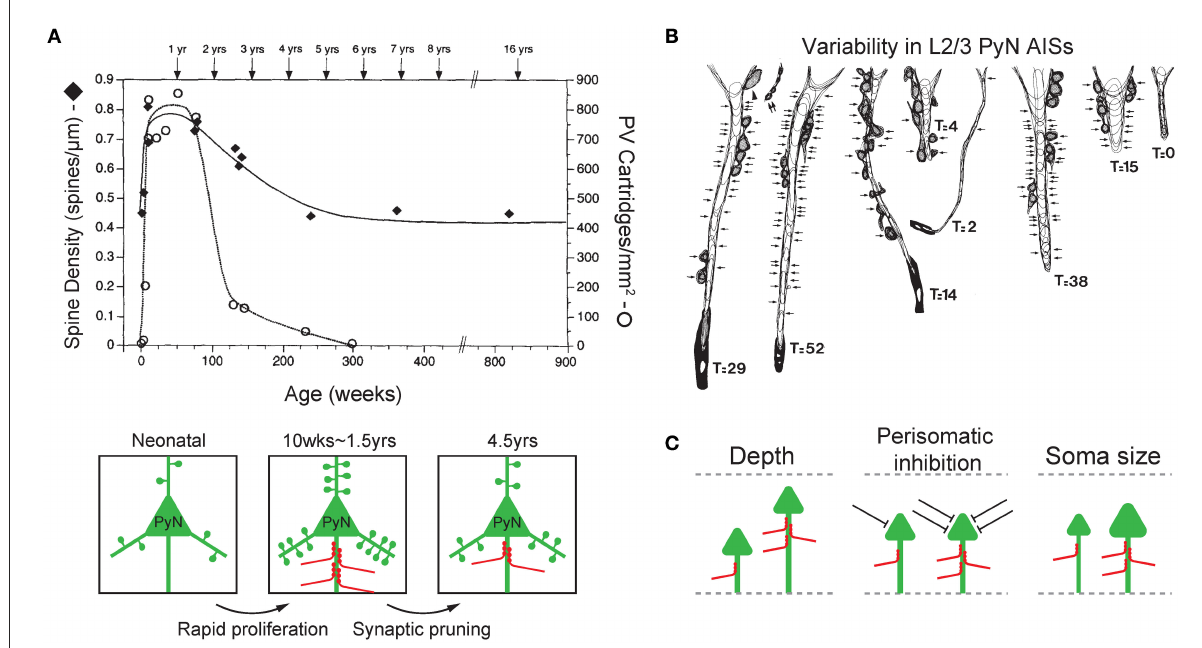
FIGURE2 Plasticity and variability of axo-axonic synapses. (A) Synchronous developmental time course of changes in PyN spine density (filled diamonds) and ChC cartridge density (blank circle) in the L3 monkey prefrontal cortex. Both PyN dendritic spine density and ChC cartridge density rapidly increase during 2–3 post-natal months (rapid proliferation), reach their highest levels at 1.5 years of age, progressively decline until 4.5 years of age (synaptic pruning), then remain stable in early adulthood. Adapted from Anderson et al. (1995). (B) Variability in the ChC axon terminals on AISs of L2/3 PyNs of the monkey sensory-motor cortex. Arrows indicate synaptic contacts only on the AIS. T indicates the total number of synapses on the AIS (GAD-positive). Adapted from DeFelipe et al. (1985). (C) Features of target PyNs correlated with axo-axonic synaptic strength. The cortical depth of PyN soma location (left), the degree of perisomatic inhibition (middle), and the size of PyN soma (i.e. soma area and AIS radius, right) are positively correlated with the strength of ChC inputs to the AIS. Adapted from Schneider-Mizell et al.